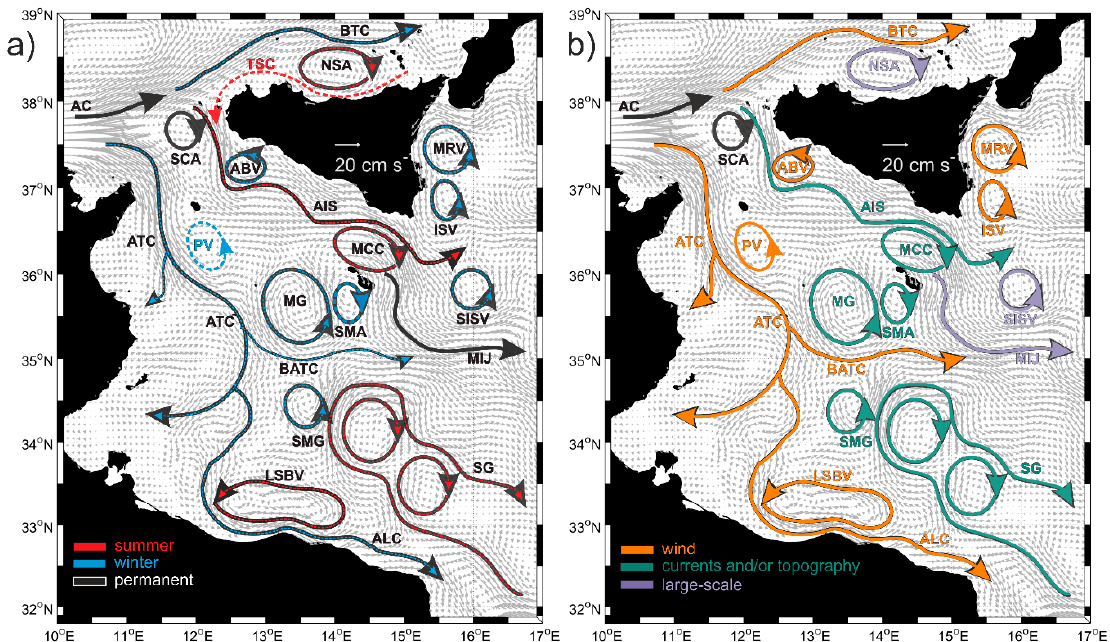
Figure 17. Schematized representation of the mean surface circulation in the Sicily Channel and Southern Tyrrhenian Sea (black arrows), based on the mean optimal current circulation map depicted in Figure 2b (bright grey vectors). ( a ) Black arrows emphasize the permanent sub-basin and mesoscale structures; dashed red/blue lines emphasize the seasonal summer/winter structures, respectively; red/blue arrows are superimposed on the black arrows when the structures are permanent but most intense in summer/winter, respectively. ( b ) Sub-basin and mesoscale structures are classified according to the mechanisms that drive them, wind forcing (orange arrows), the interaction between currents and topographical forcings (light green arrows), and large-scale internal processes (light purple arrows).